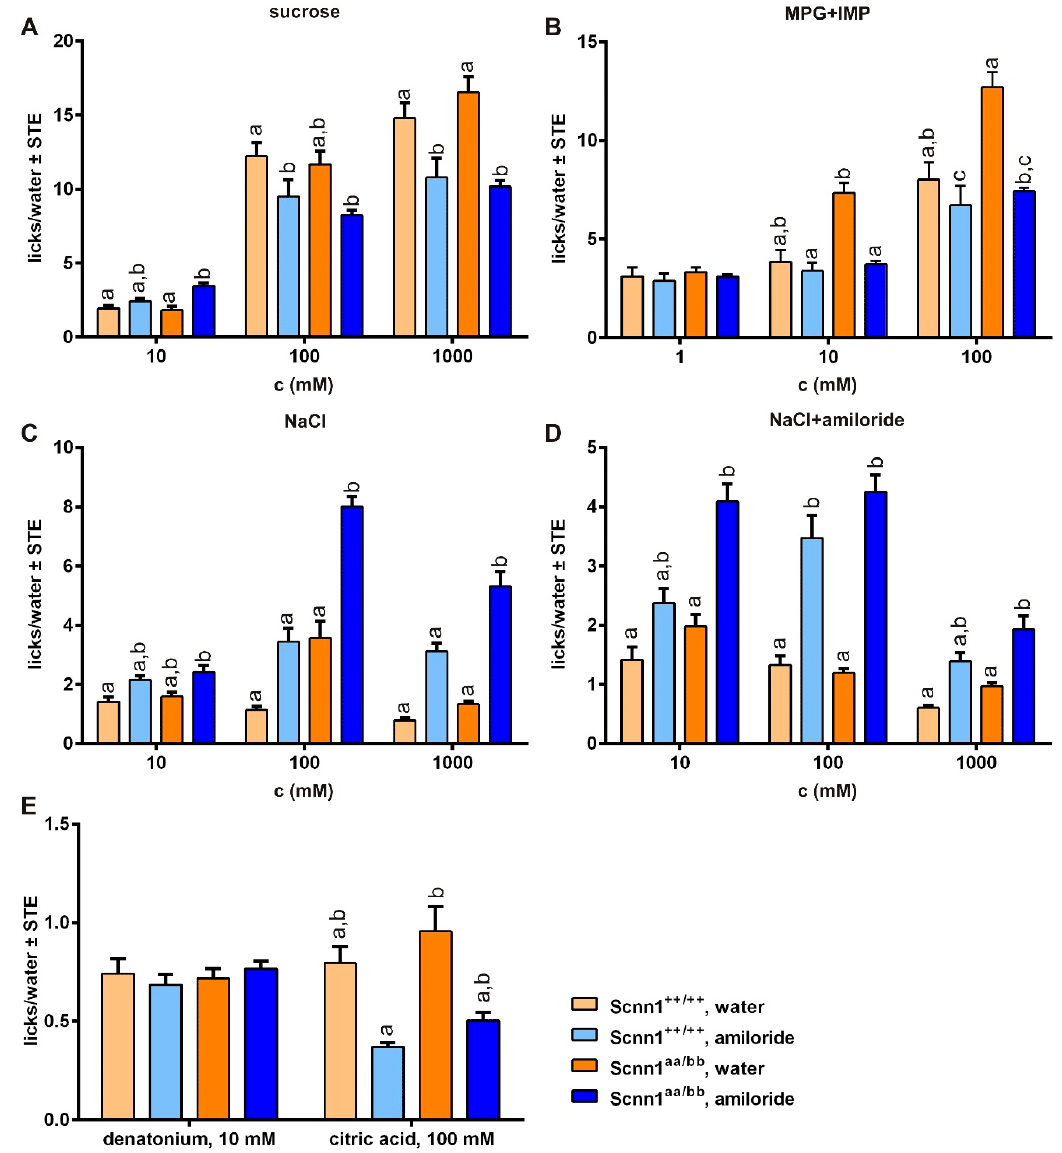
Figure 5. Taste responses of Scnn1 ++/++ and Scnn1 aa / bb mice after access to amiloride-containing water. Scnn1 ++/++ and Scnn1 aa / bb mice receiving a sodium-adequate diet had either access to 300 µ M amiloride-containing water 13 h prior to restriction starting or received water without amiloride. The restriction phase lasted for 22.5 h with access to 2.0 mL water ± 300 µ M amiloride and 1 g of food. Lick responses to di ff erent concentrated solutions of sucrose ( A ), monopotassium glutamate with inosine 5´monophosphate (MPG + IMP; B ), sodium chloride (NaCl; C ), NaCl with amiloride (NaCl + amiloride; D ), or bitter and sour stimuli ( E ) were determined by an automated gustometer. Each data point represents a mean ± SE of 5 s presentations from 10 to 16 animals tested. Statistical was testing based on UNIANOVA and post-hoc analysis using Bonferroni´s multiple comparison test. Di ff erent letters indicate statistical significance.